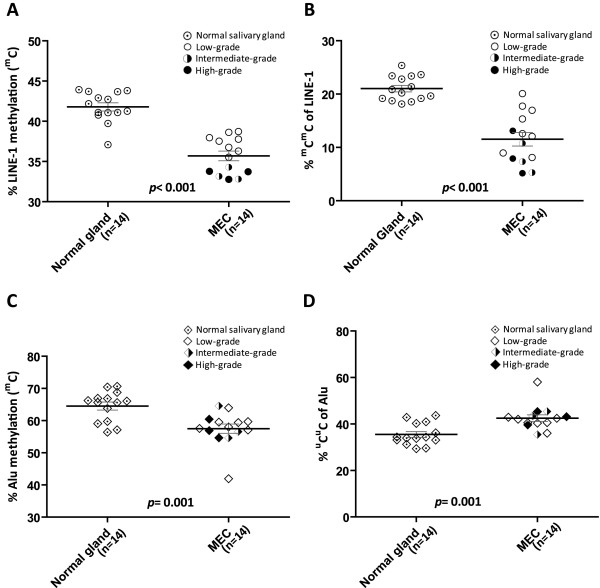
Comparison of total LINE-1 and Alu element methylation between normal salivary gland tissue and whole MEC tissue. (A, B) The frequency of mC and mCmC of LINE-1 methylation in whole MEC tissue was significantly lower than in normal salivary gland tissue (p<0.001). (C) The frequency of mC of Alu elements in whole MEC tissue was significantly lower than in normal salivary gland tissue (p=0.001). (D) The frequency of uCuC Alu elements in whole MEC tissue was significantly higher than in normal salivary gland tissue (p=0.001).